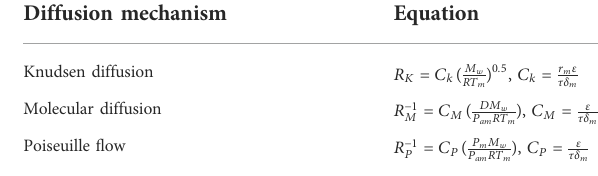
TABLE 2 Speci fi cation of the heat pump (Underwood, 2015). TABLE 3 Diffusion models of the DCMD process (Ding et al.,